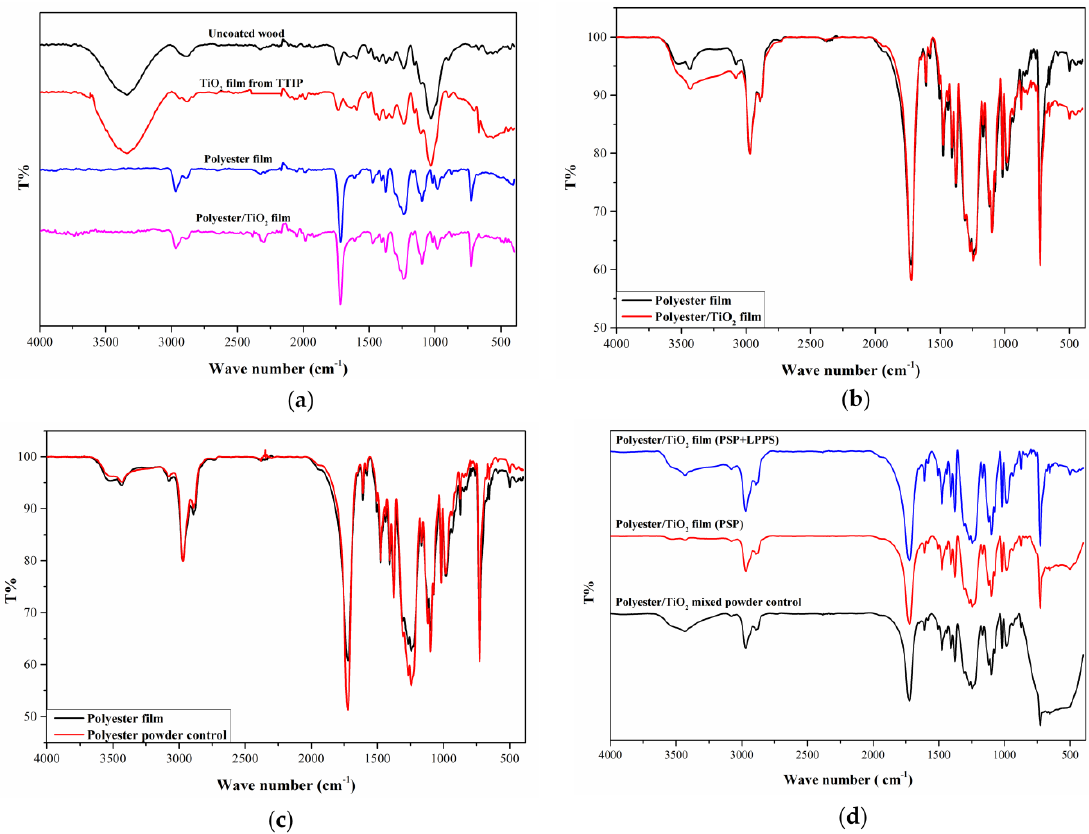
Figure 4. ( a ) FTIR–ATR spectra for uncoated wood and coated wood; ( b ) FTIR spectra for polyester and polyester / TiO 2 films; ( c ) FTIR spectra for polyester powder reference and polyester film; ( d ) FTIR spectra for polyester / TiO 2 powder reference and polyester / TiO 2 films.